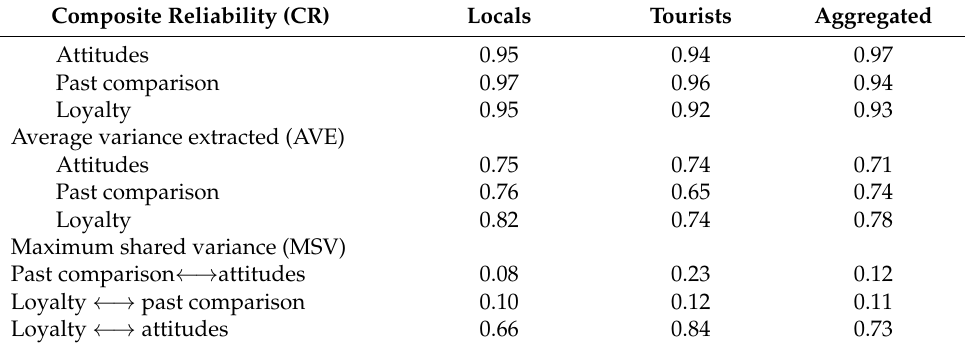
Table 5. Composite reliability, average variance extracted, and maximum shared variance.